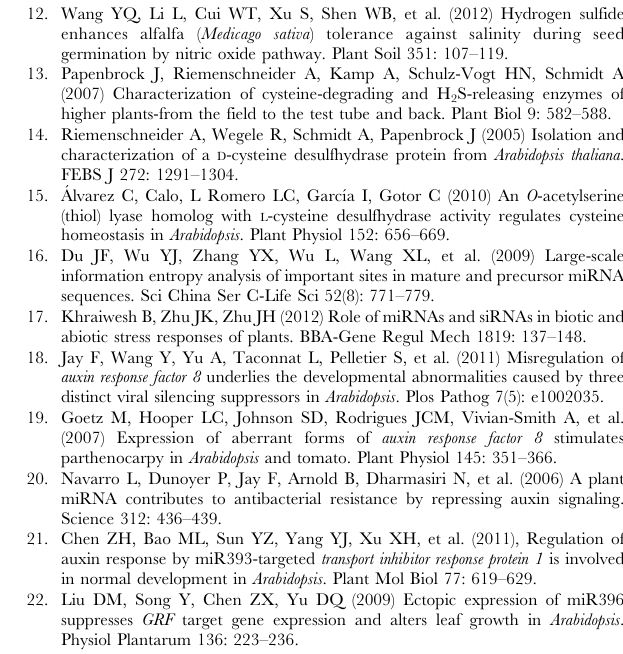
Figure 10. Summary of H 2 S regulating miRNAs in response to drought stress. Solid lines: direct effects; dotted lines: intermediates remain elusive; arrows: enhanced expression; hyphen: suppressed